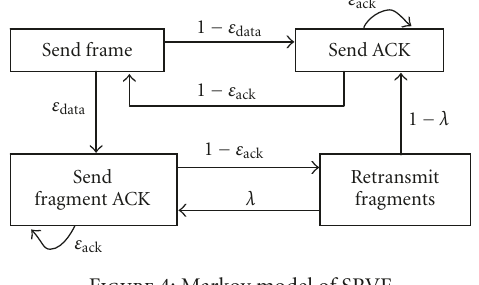
Figure 4: Markov model of